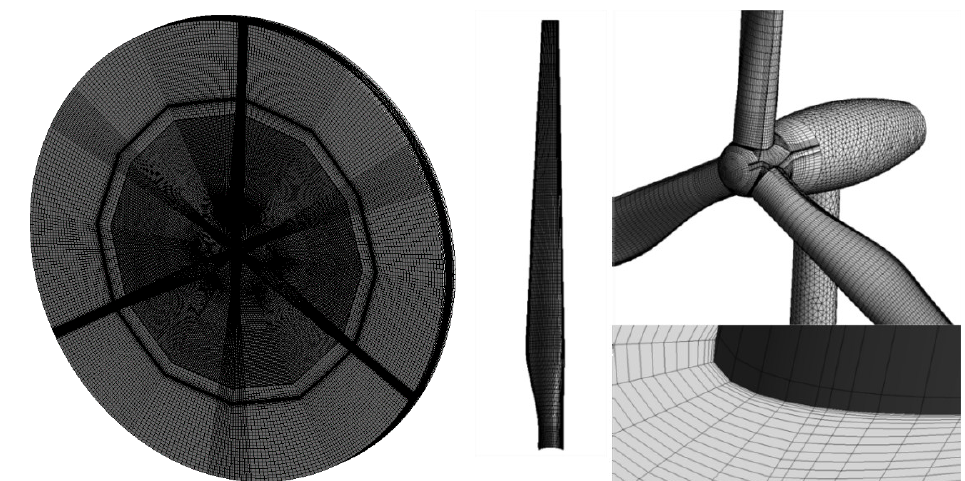
Figure 3. Rotational region and blade surface mesh